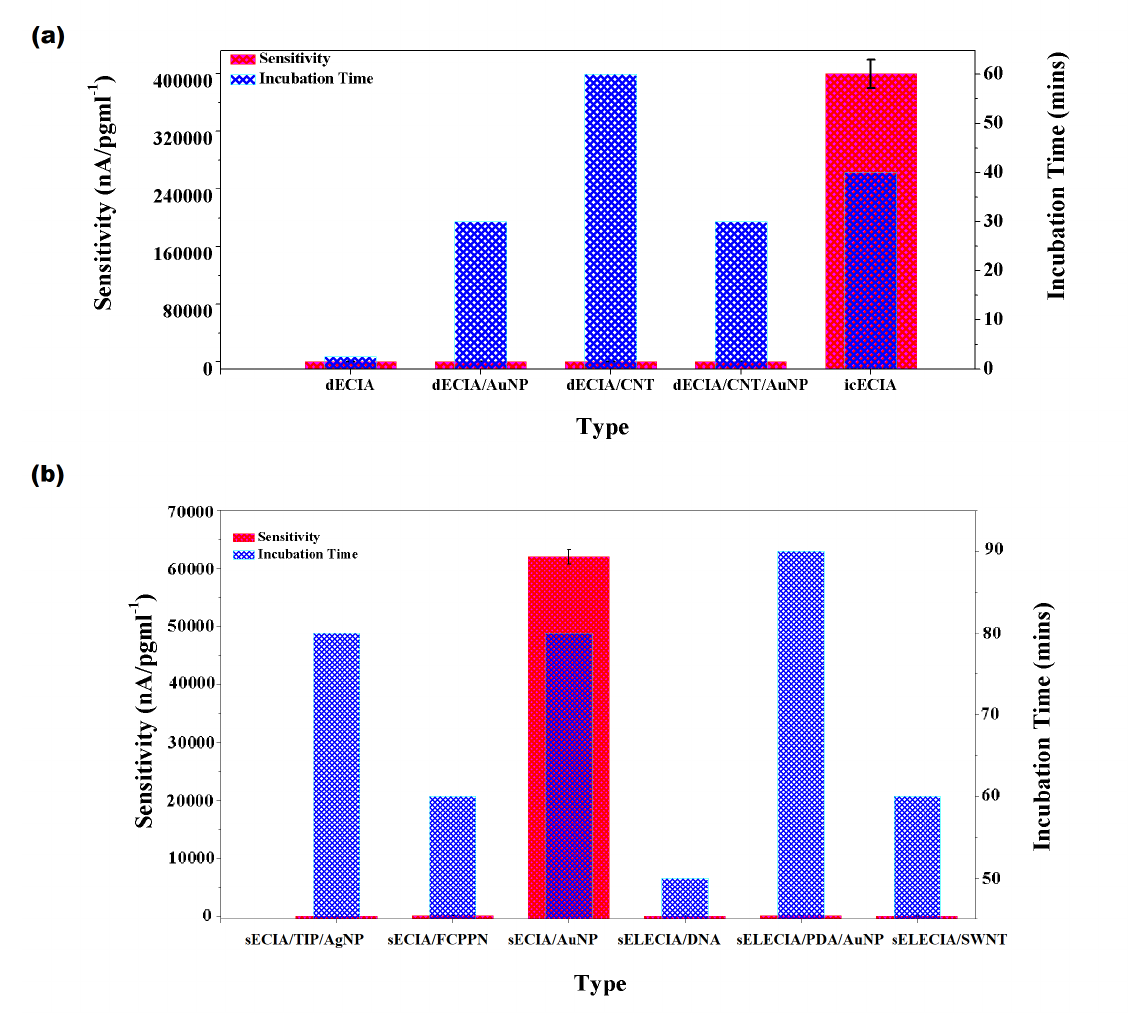
Figure 5. Sensitivity of ( a ) direct electrochemical immunoassay/dECIA and indirect competitive electrochemical immunoassay/icECIA (calculated/obtained from [100–104]); ( b ) sandwich electrochemical immunossay/sECIA with nanomaterial or enzyme label/sELECIA (calculated/ obtained from